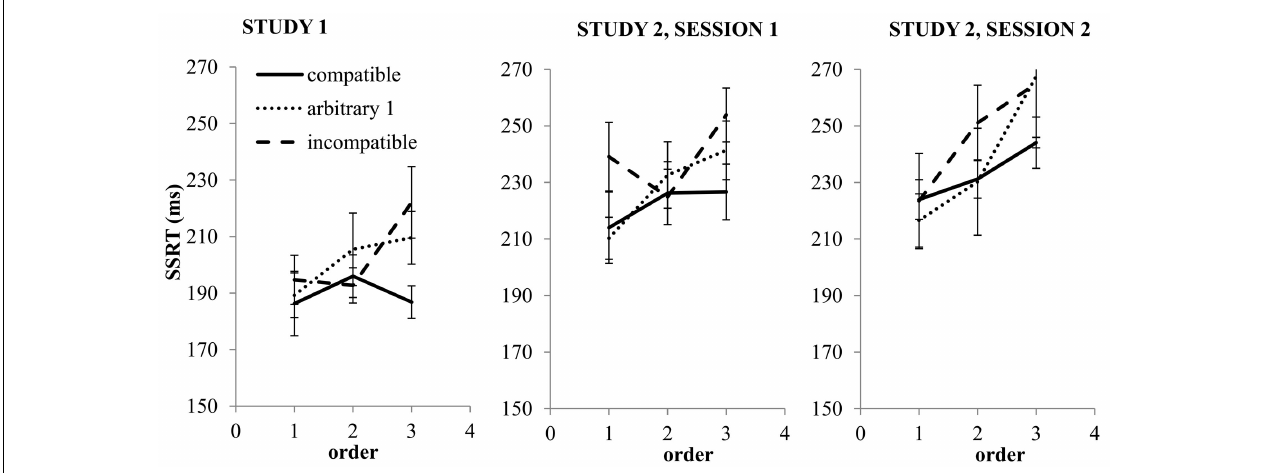
FIGURE 2 | Mean SSRT (error bars denote ± 1SEM) as a function ofTask (compatible, arbitrary 1 or incompatible) and as a function of task order